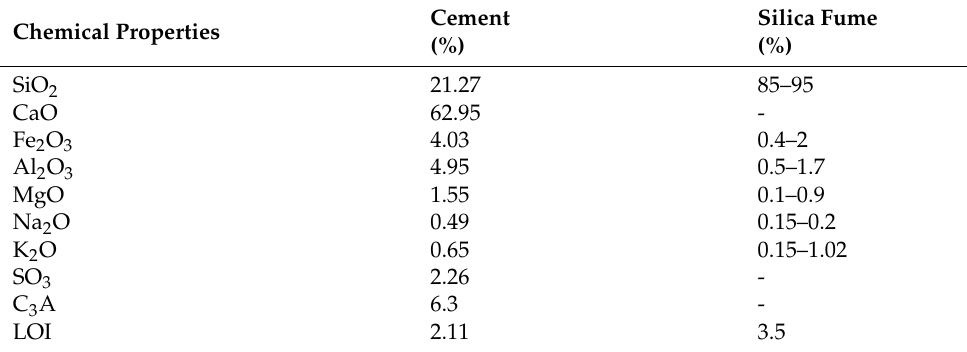
Table 1. Chemical properties of cement and silica fume.